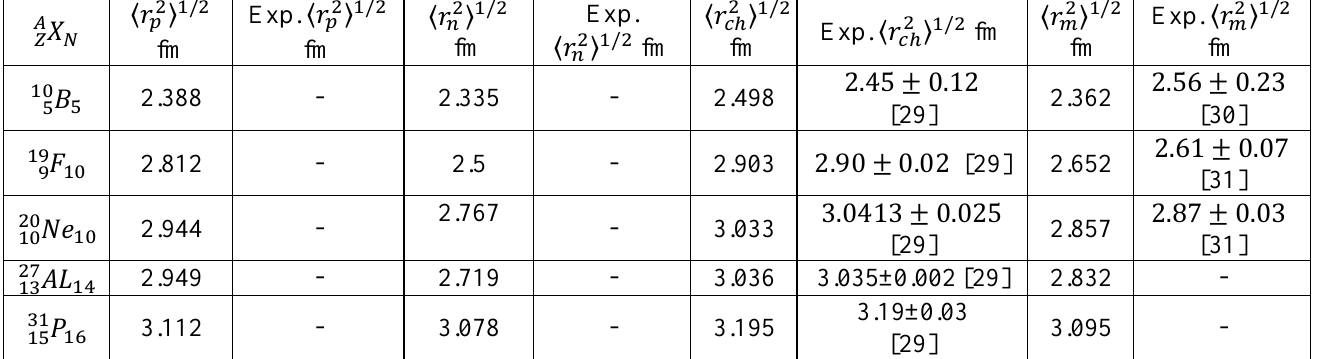
Table 3: Calculated radii for stable nuclei compared with available eperimentl data.